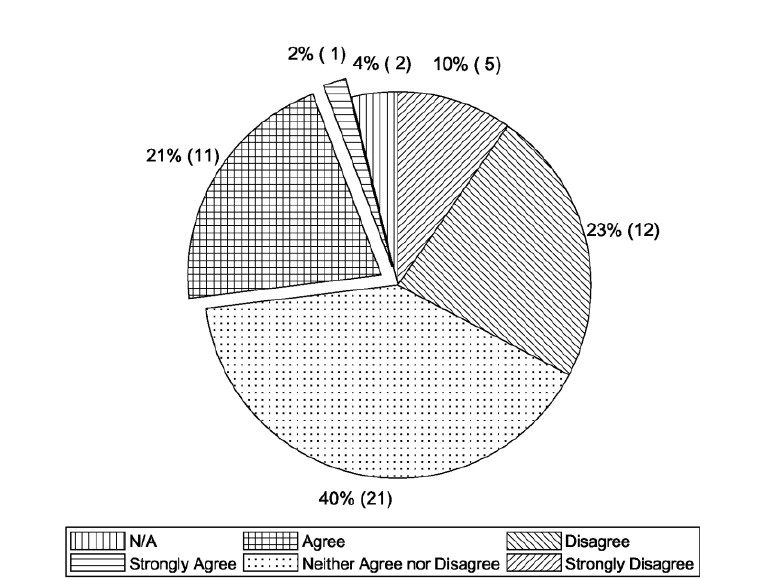
Fig. 13. Projects affect students who intended to study engineering before taking this course to decide not to study